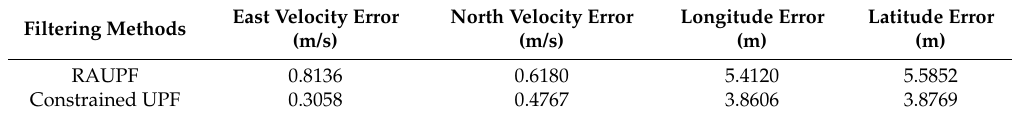
Table 2. Mean errors of velocity and position under the wind speed of 15 m/s.